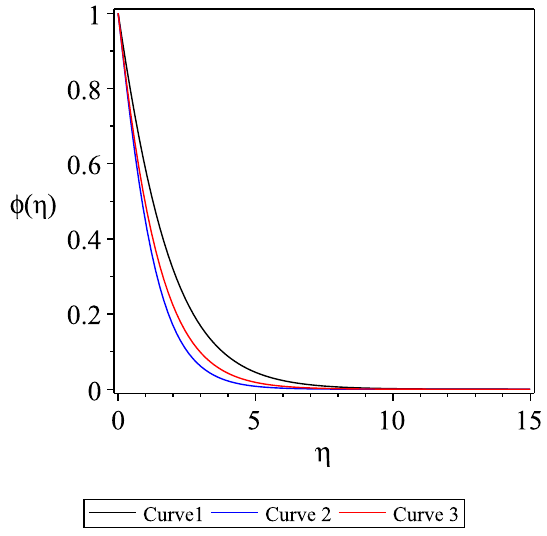
Fig. 8 Plot of (cid:98) φ ( η ) , where Curve 1 has Le = 2, Nb = 2, Pr = 1, Nt = 1, n = 0 . 5, Curve 2 has Le = 3, Nb = 1, Pr = 5, Nt = 0, n = 1, and Curve 3 has Le = 2, Nb = 2, Pr = 7, Nt = 0 . 5, n = 0 . 8 using their respective error-minimizing convergence control